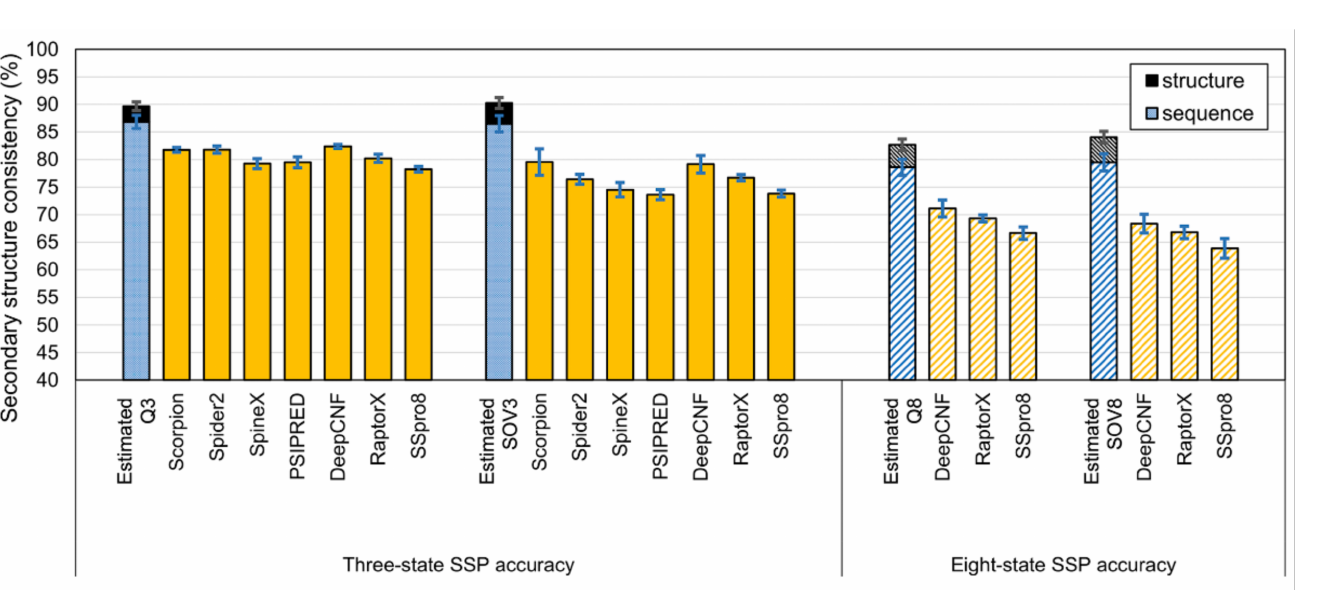
Figure 6. Accuracies of state-of-the-art SSP methods evaluated with datasets sharing <90% sequence identities. This test utilized the independent query sets prepared by Yang et al. for SSP evaluations [1] and the SCOP720 query set. The source of reference sequences for PSSM generation was UniRef90-2015. The blue and black bars indicate the SSP upper limits estimated at a <90% sequence identity cutoff by sequence and structural alignments, respectively. The sequence alignment algorithm used to make those estimates was PSI-BLAST, the PSSM generator of all the tested SSP methods. These results reveal that, when the homology of the SSP query and reference sequences was <90% identity, the accuracy of current SSP methods has not reached the limit estimated by sequence alignments of homologs sharing <90% sequence identities.